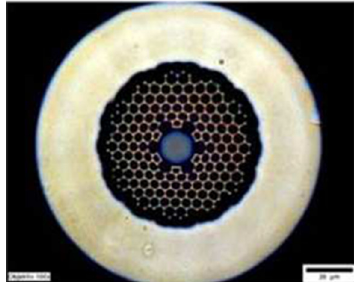
Figure 6. Cross-section image of a 7-cell hollow core PCF used for temperature measurement (Reproduced from [28], with the permission of OSA publishing).